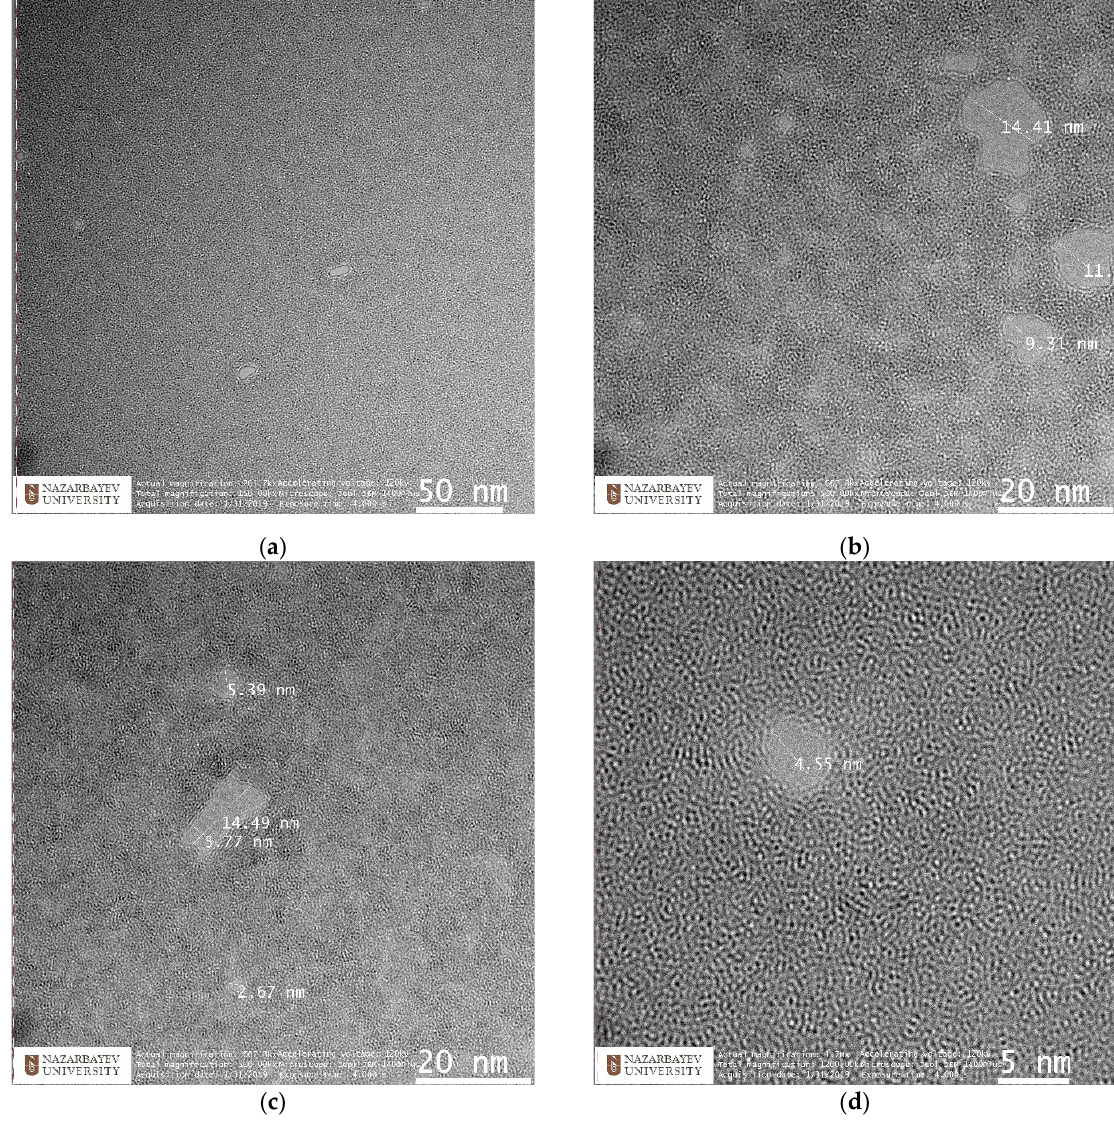
Figure 6. TEM and high resolution TEM (HRTEM) images of multiple nanopores ( a – c ) and a HR TEM image of a nanopore ( d ) on MLG irradiated with 30 keV cluster ions of (Ar n ) + (n ≈ 1000), at an ion dose of 10 14 ion/cm 2